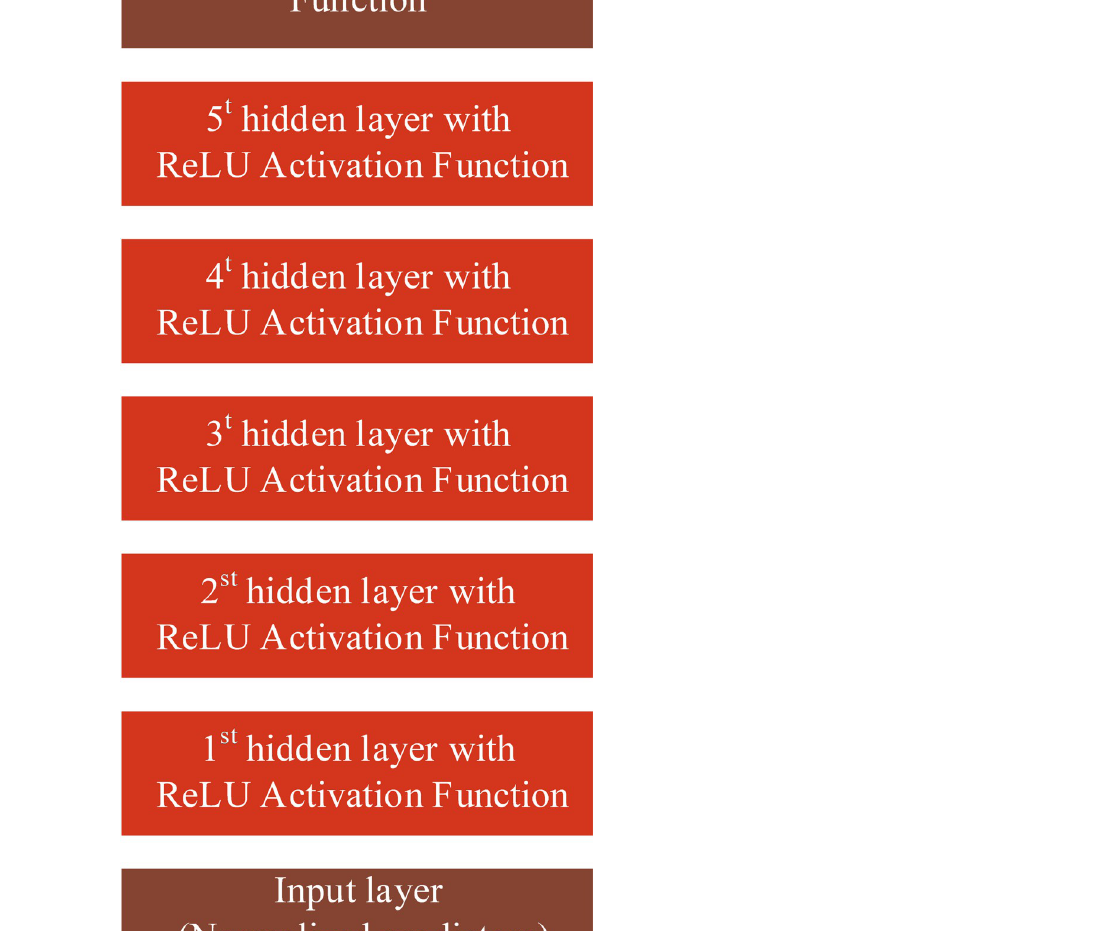
preprocessed ML models than the models with no preprocessing. The K-Nearest Neighbor